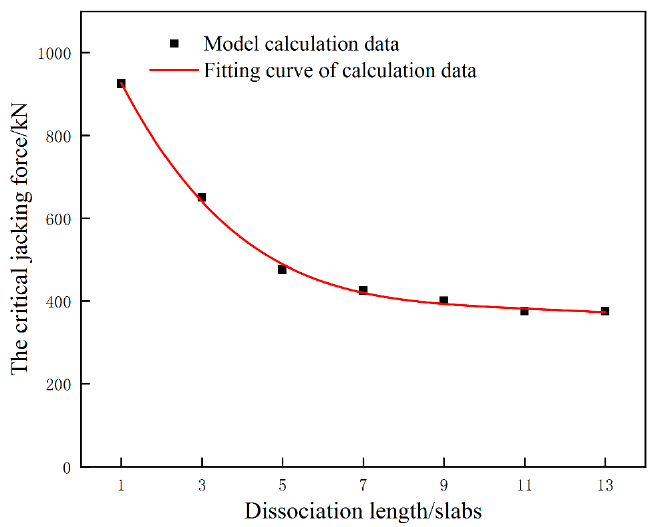
Figure 13. The critical jacking force corresponding to different dissociation lengths under single point jacking condition. jacking